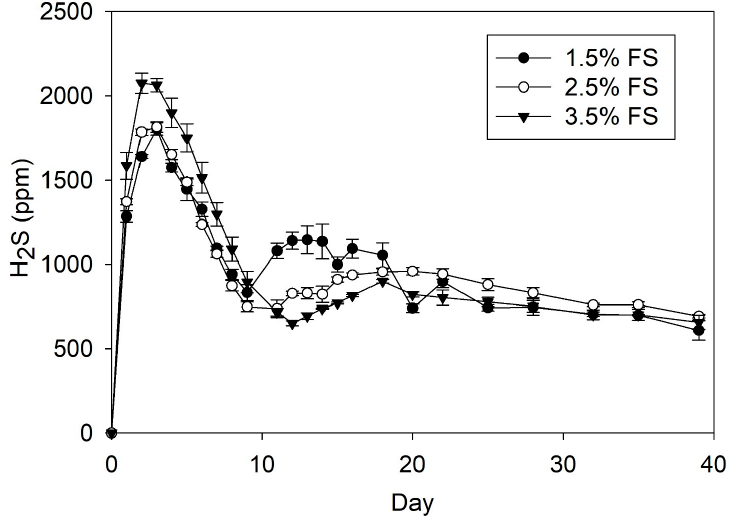
Figure 3. Variation of hydrogen sulfide concentrations in the biogas with fish sludge as the anaerobic digestion substrate at three different initial solid concentrations.